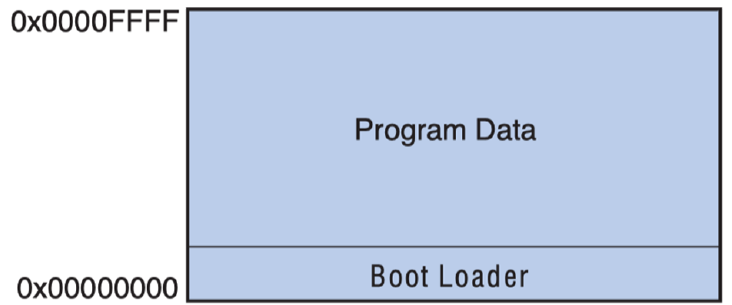
Figure 5. An NIOS II program in on-chip memory.